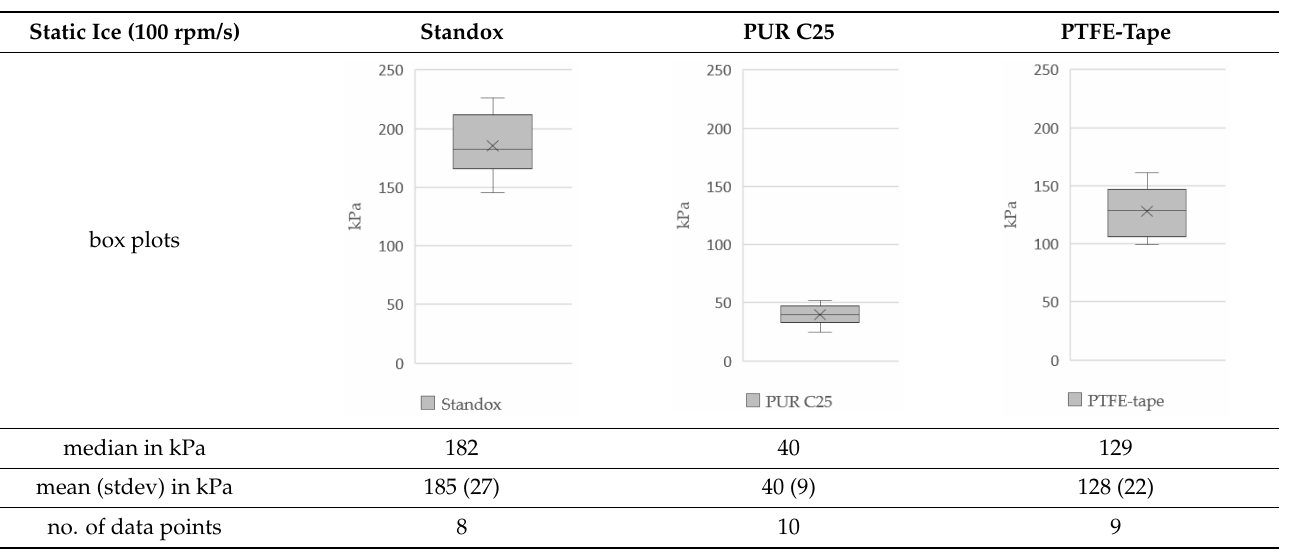
Table 9. Ice adhesion centrifuge test results for static ice (100 rpm/s) with relevant statistical data for result evaluation.